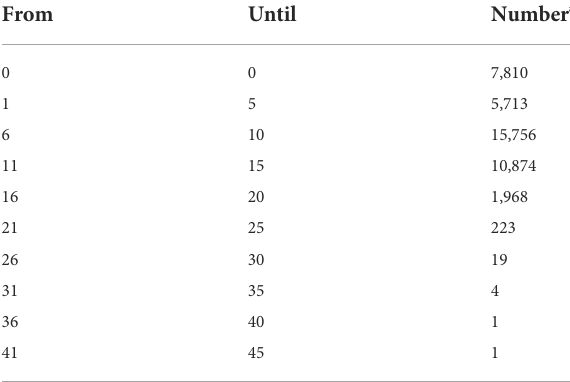
TABLE 5 Number of SPP sub-subcategories per procurement document. From Until